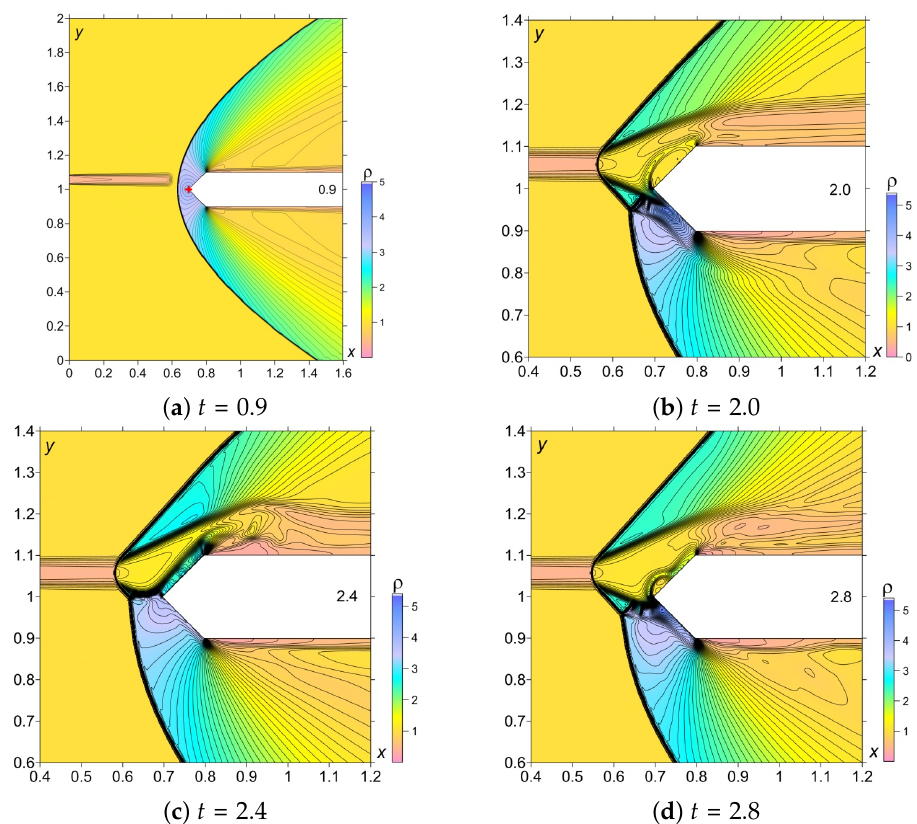
Figure 44. Density contours showing oscillatory behavior. Adapted from [94].